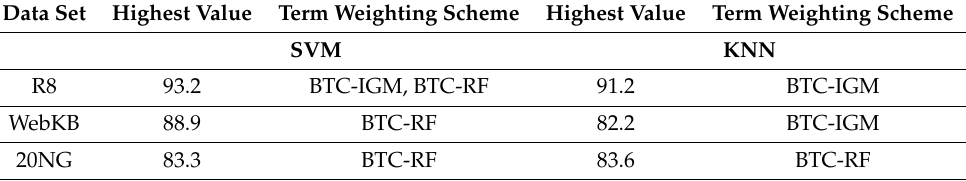
Table 11. Summary: Best Text Classification